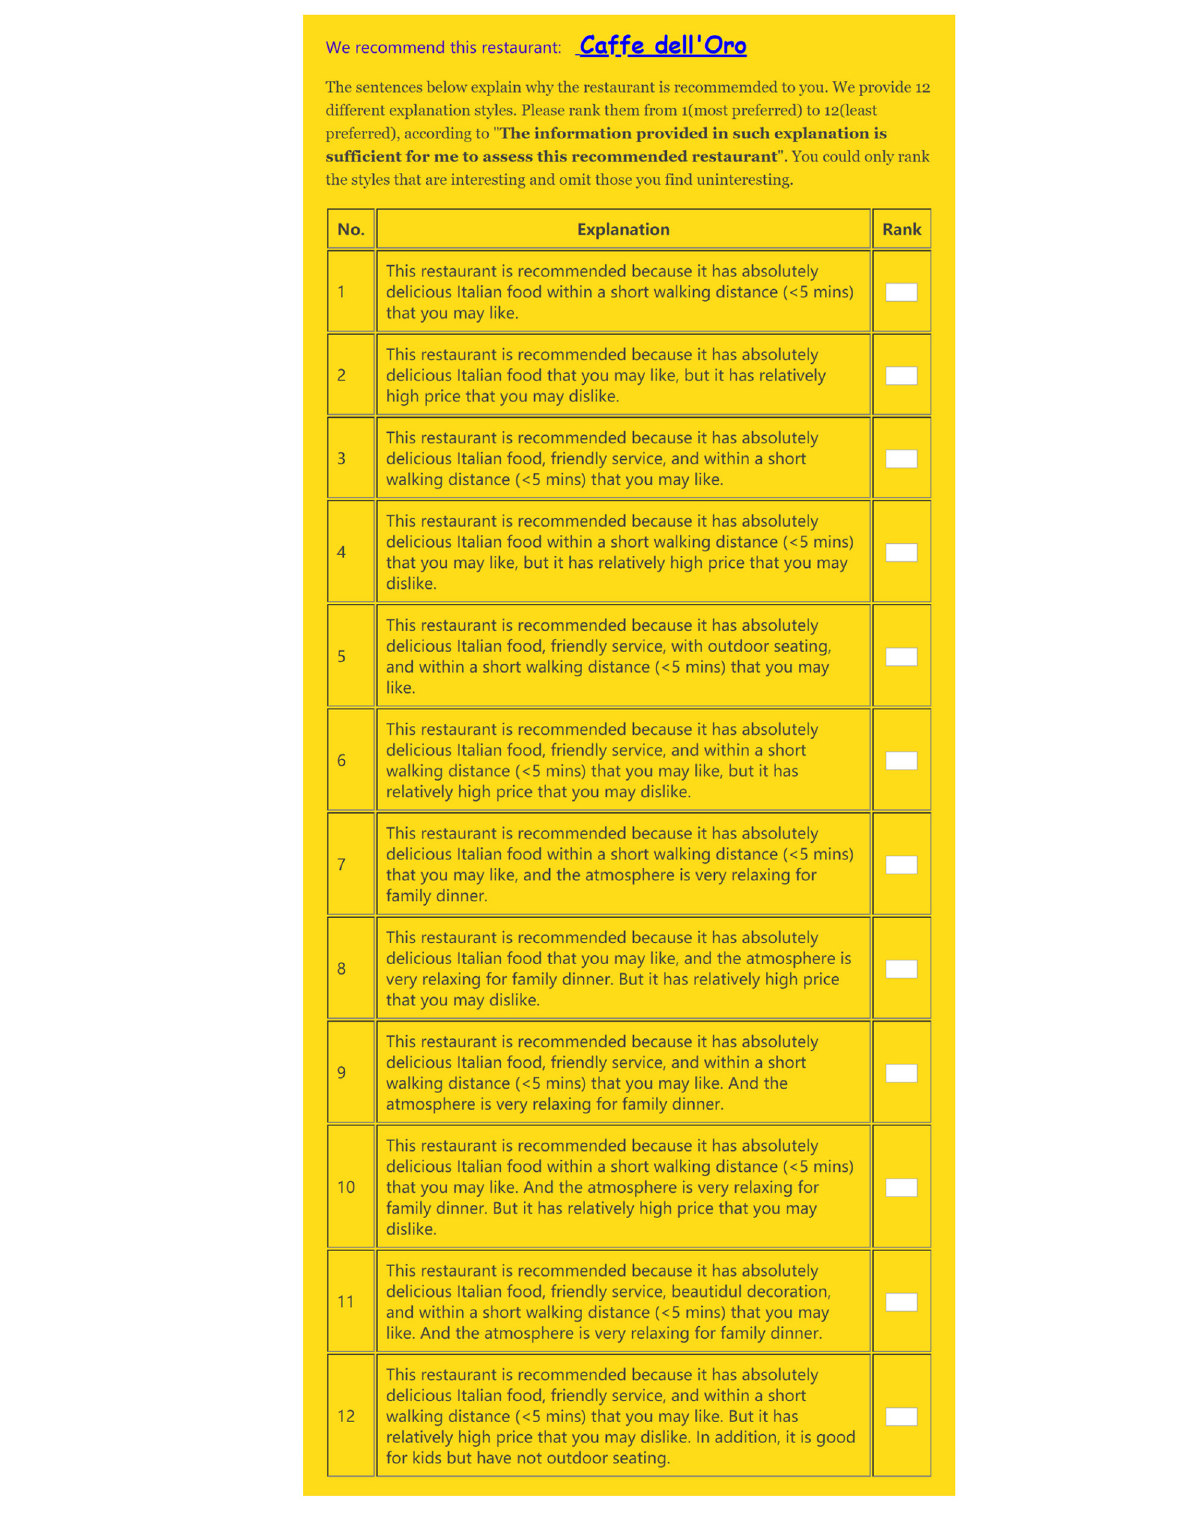
FIGURE 1 | (Pilot study) The display order of all explanations was randomized among participants.